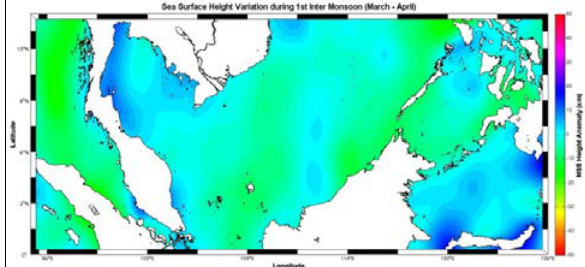
Figure 6. The Sea Surface Height Variation during 1 st Inter Monsoon